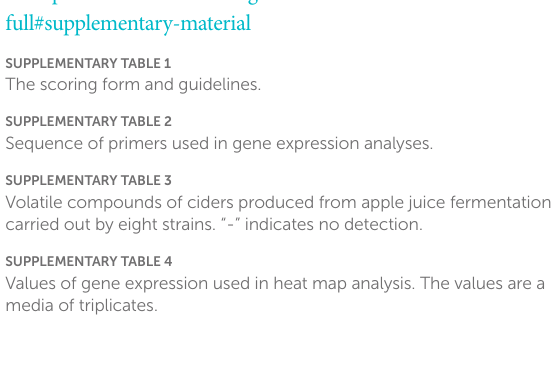
SUPPLEMENTARY TABLE 1 The scoring form and guidelines. SUPPLEMENTARY TABLE 2 Sequence of primers used in gene expression analyses. SUPPLEMENTARY TABLE 3 Volatile compounds of ciders produced from apple juice fermentation carried out by eight strains. “-” indicates no detection. SUPPLEMENTARY TABLE 4 Values of gene expression used in heat map analysis. The values are a media of